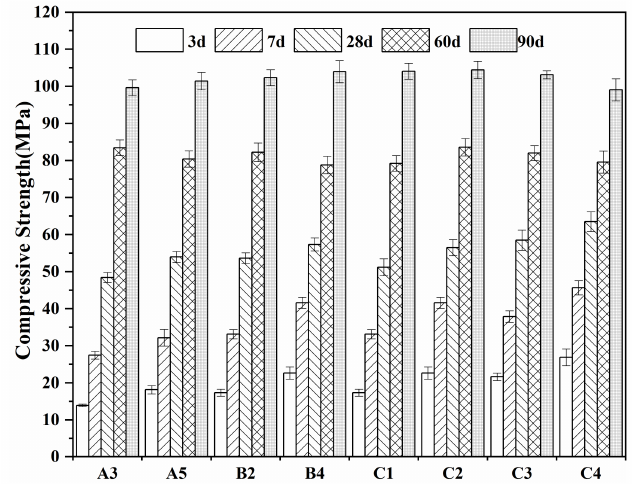
Figure 12. Compressive strength of A3, A5, B2, B4,